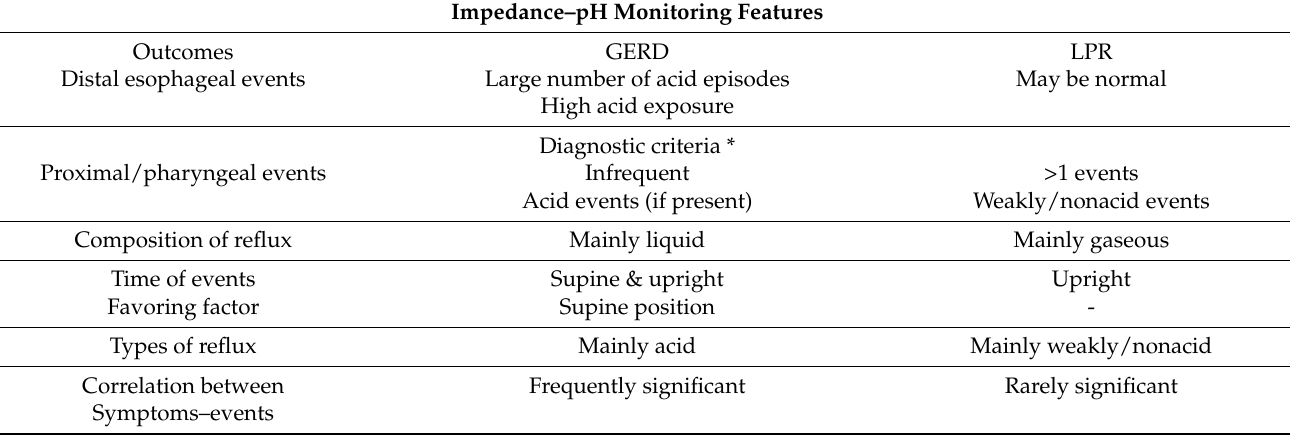
Table 3. pH–impedance differences between gastroesophageal reflux disease and laryngopharyngeal